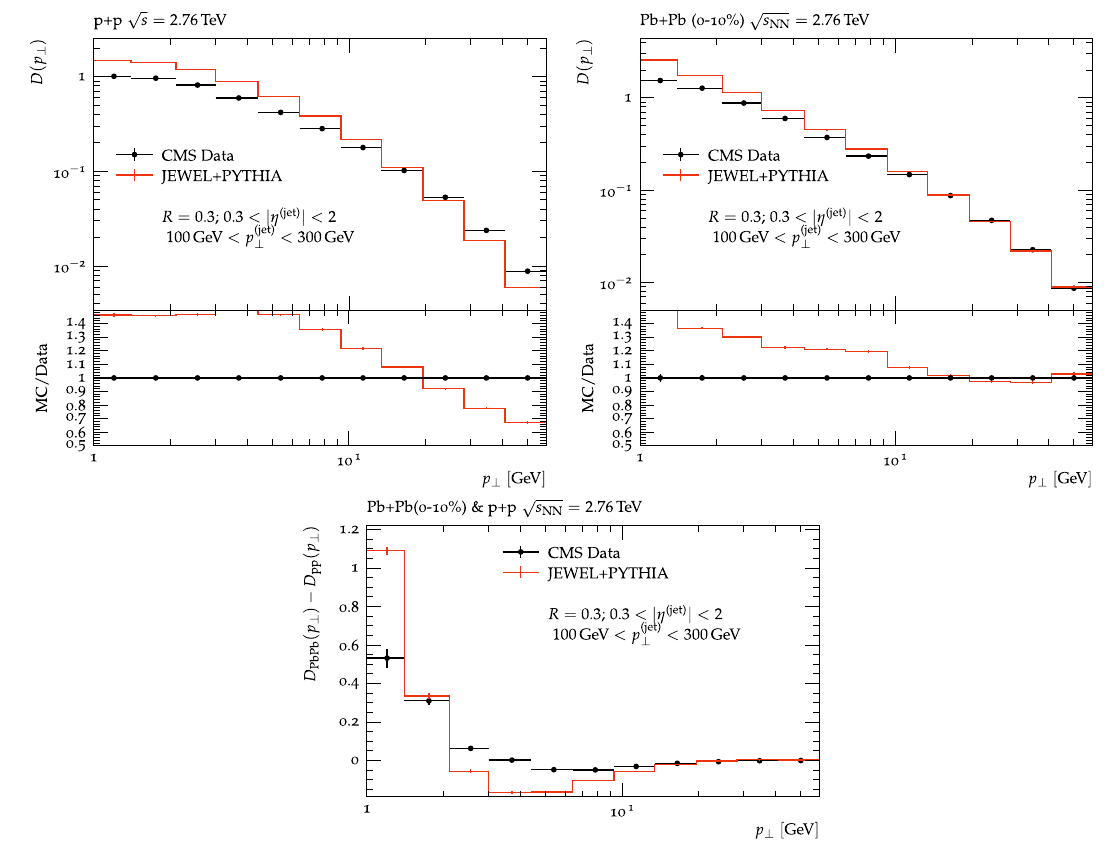
( jet ) < 300 GeV and 0 . 3 < | η ( jet ) | < 2 anti- k ⊥ jets with 100 GeV < p ⊥ in p+p and Pb+Pb (0 − 10% centrality) collisions. JEWEL+PYTHIA results are shown with constituent subtraction for charged